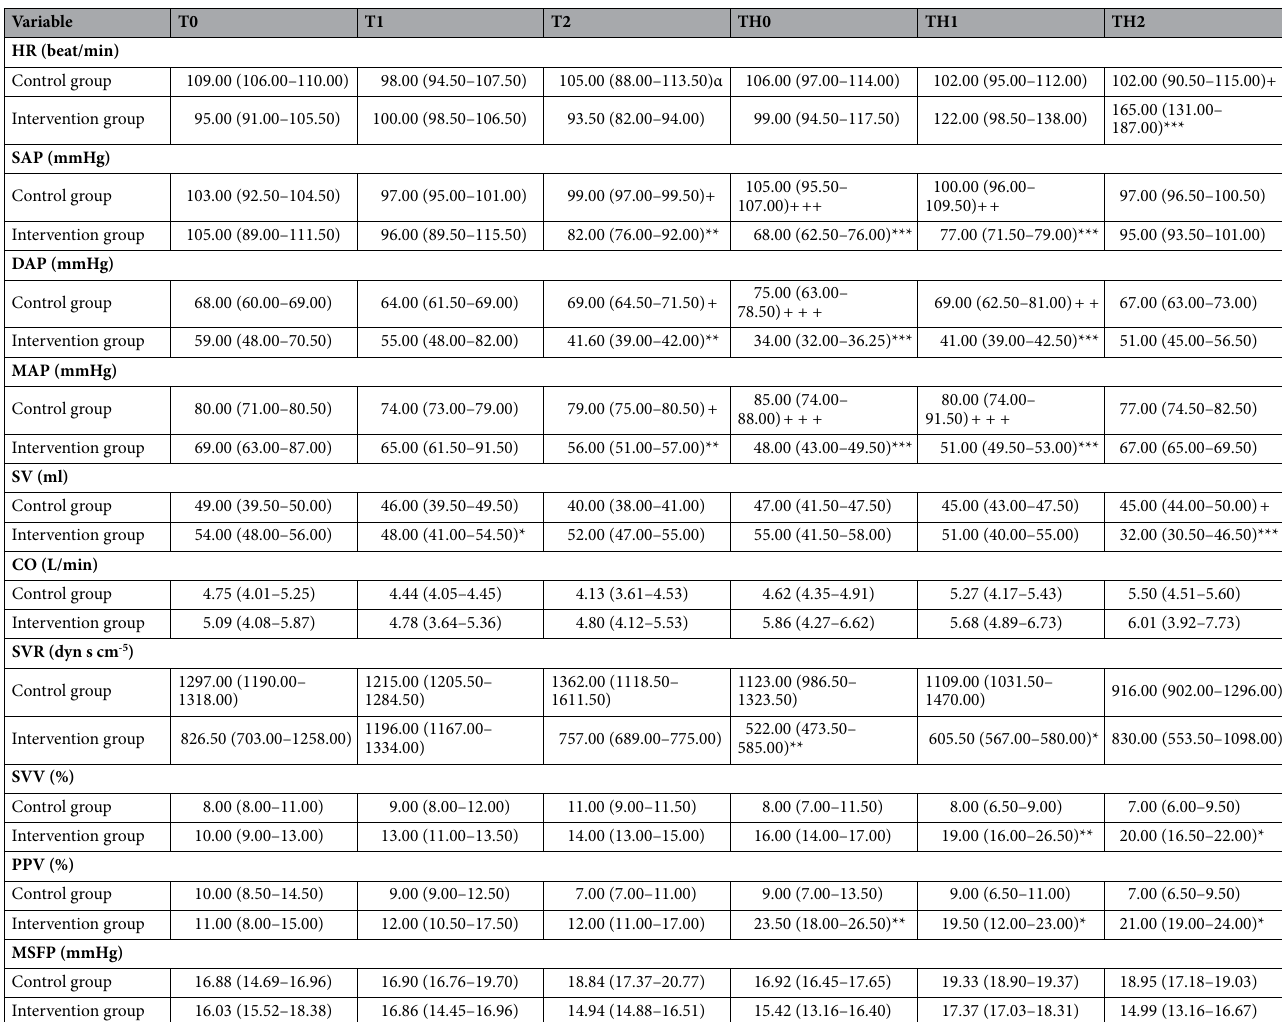
Table 1. Hemodynamic variables. Data are shown as median and interquartile range. CO cardiac output, DAP diastolic arterial pressure, HR heart rate, MAP mean arterial pressure, MSFP mean systemic filling pressure, PPV pulse pressure variation, SAP systolic arterial pressure, SVR systemic vascular resistance, SV stroke volume. T0, baseline in both groups; T1, 1 h after T0; T2, 2 h after T0; TH0, when an MAP < 50 mm Hg was reached. In the control group, this time was set at 3 h of observation. TH1, 1 h after TH0; TH2, 2 h after TH0. + = p < 0.05, + + = p < 0.01, + + + = p < 0.001 to comparison between Control and Intervention Group. * = p < 0.05, ** = p < 0.01, *** = p < 0.001 to comparison between each time and the basal time on intervention